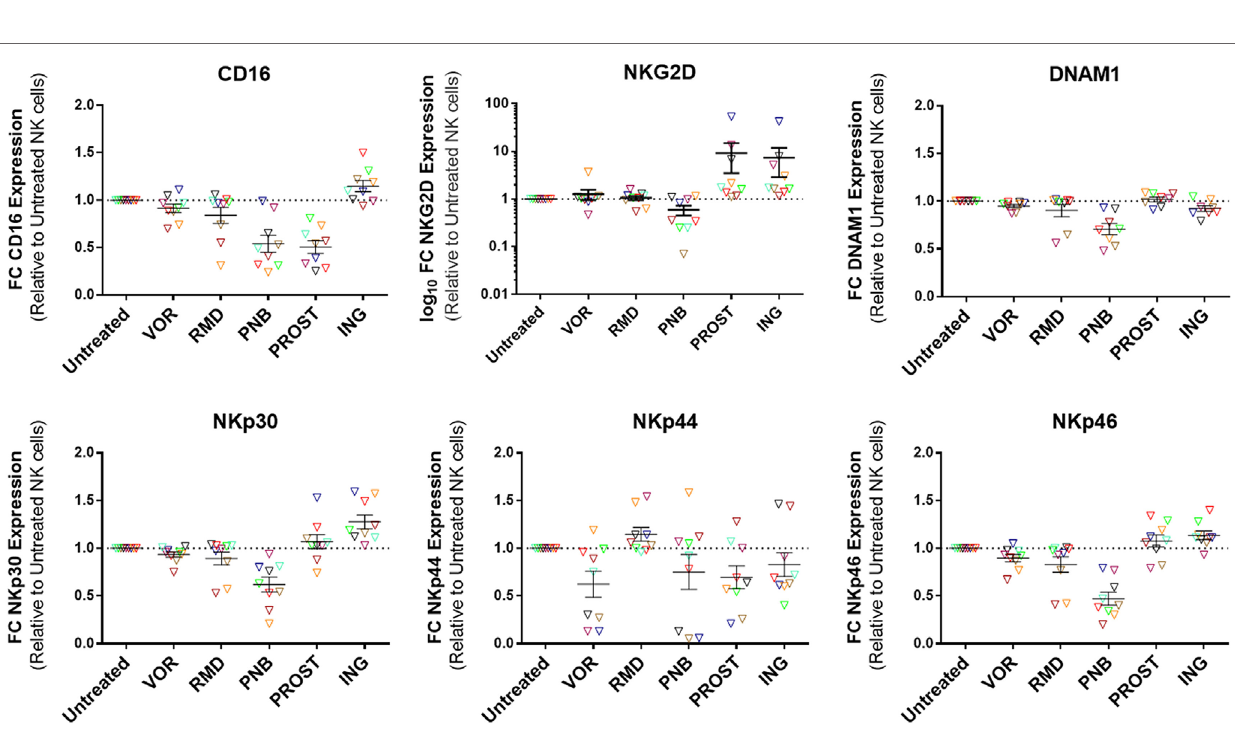
FigUre 6 | expression of activating receptors on nK cells . Results are expressed as fold change relative to untreated NK cells and each color represents cells from a different donor. PNB caused a general decrease in the expression of activating receptors, as opposed to ING, which caused a significant increase in the expression of all receptors except DNAM1 and NKp44. Of interest, PROST produced a significant increase in the expression of NKG2D. N =